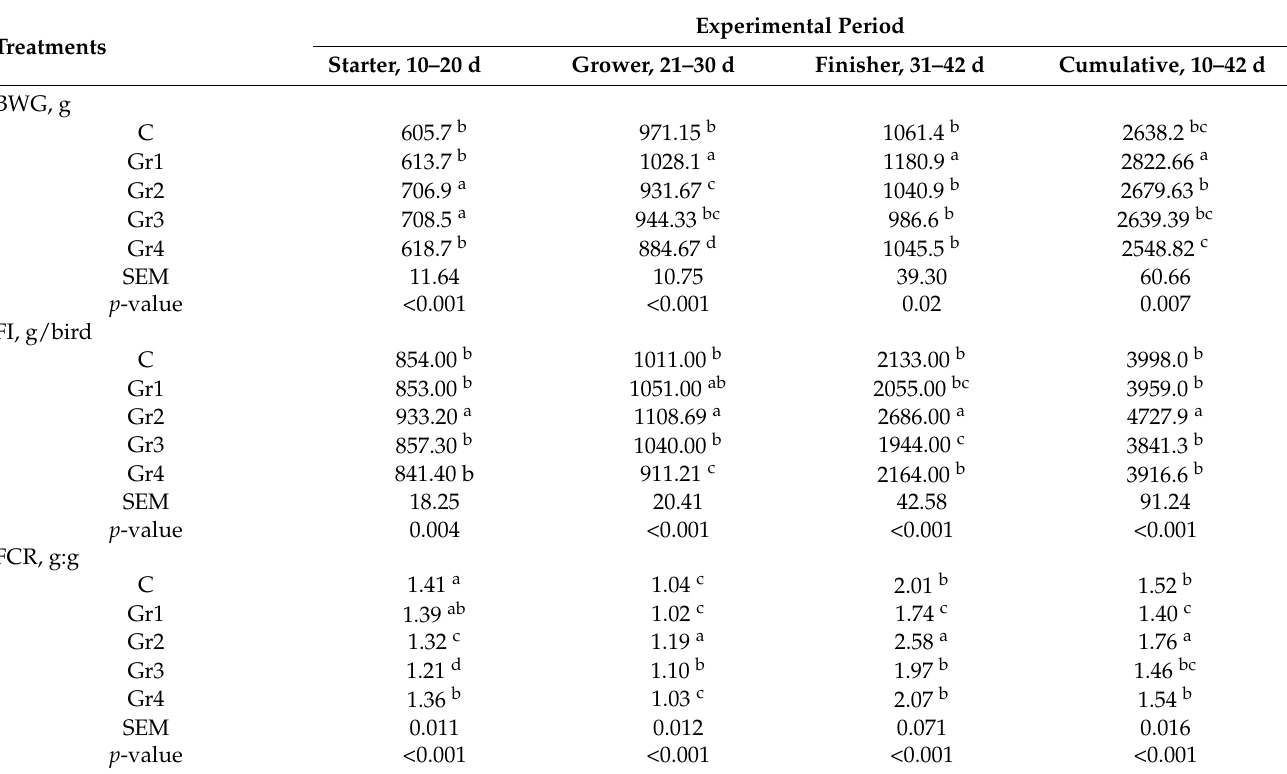
Table 4. Effects of variable concentrations of dietary CP and Lys on live body weight gain (BWG),